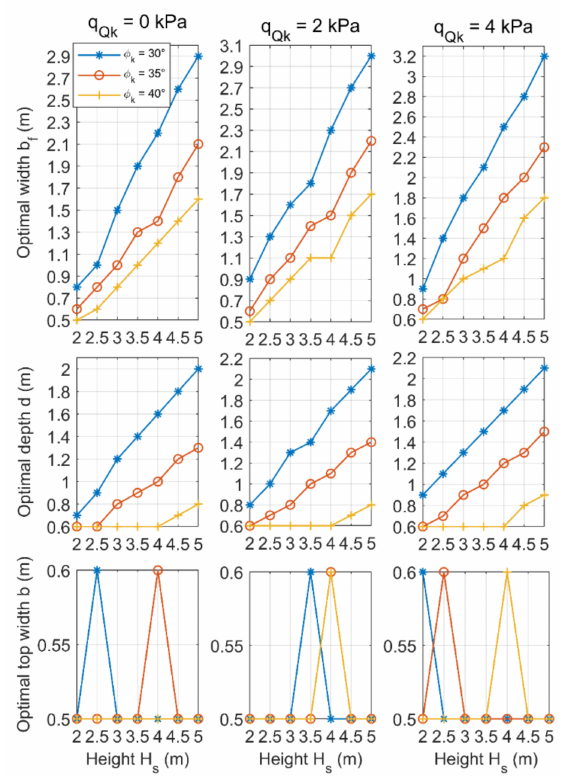
Figure 4. Optimal design for k = 0.5, β = 0 ◦ and γ = 18 kN/m 3 .